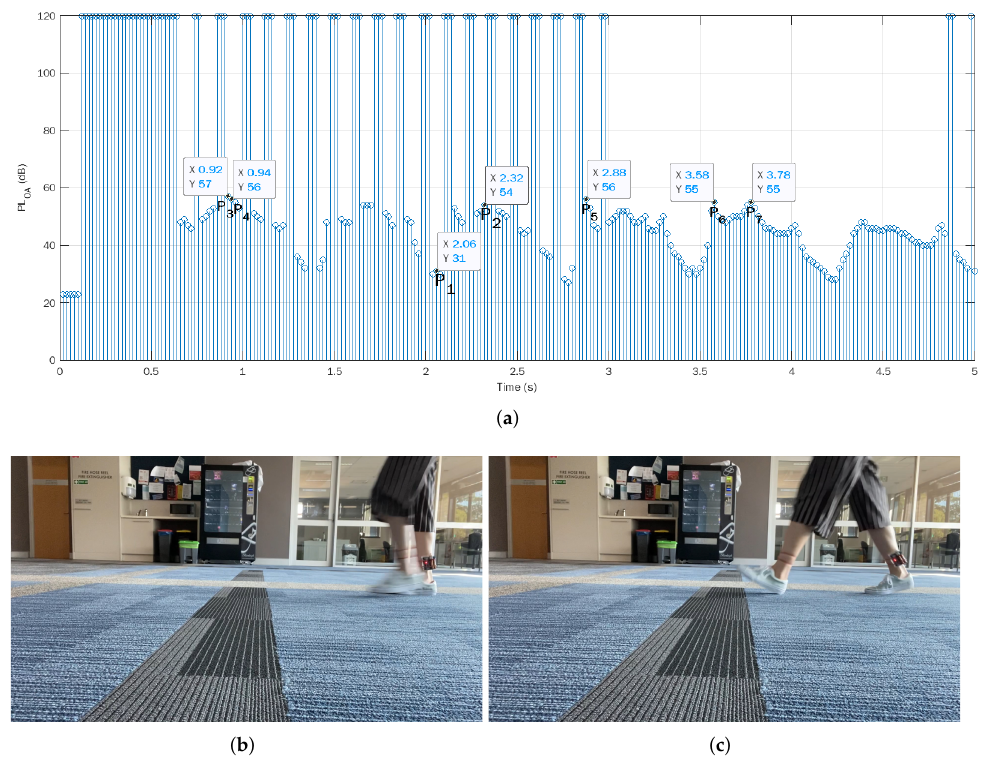
Figure 3. Trial indoor walking experiment. ( a ) On-ankle path loss at different time; ( b ) feet positions at P 1 (t = 2.08 s); ( c ) feet positions at P 2 (t = 2.32